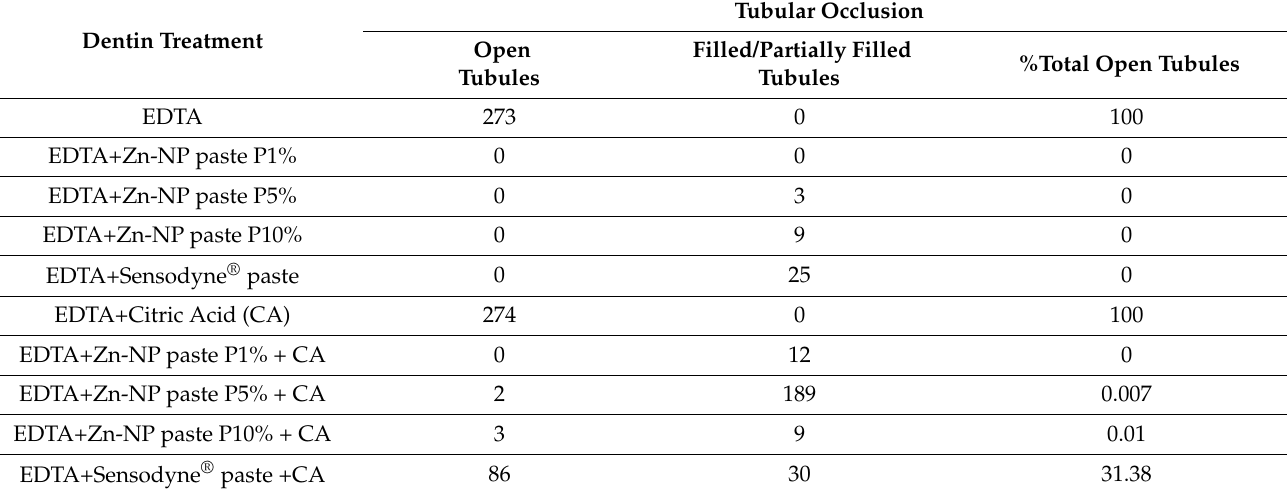
Table 2. Tubular occlusion assessment for the several treated dentin surfaces. The number of open, partially filled or filled observed tubules is displayed. The percentage of total open tubules (%Total) was measured by dividing the mean of open tubules for each group by the total number of tubules shown in the EDTA or EDTA+CA control images ((open tubules)/total number of control images × 100).